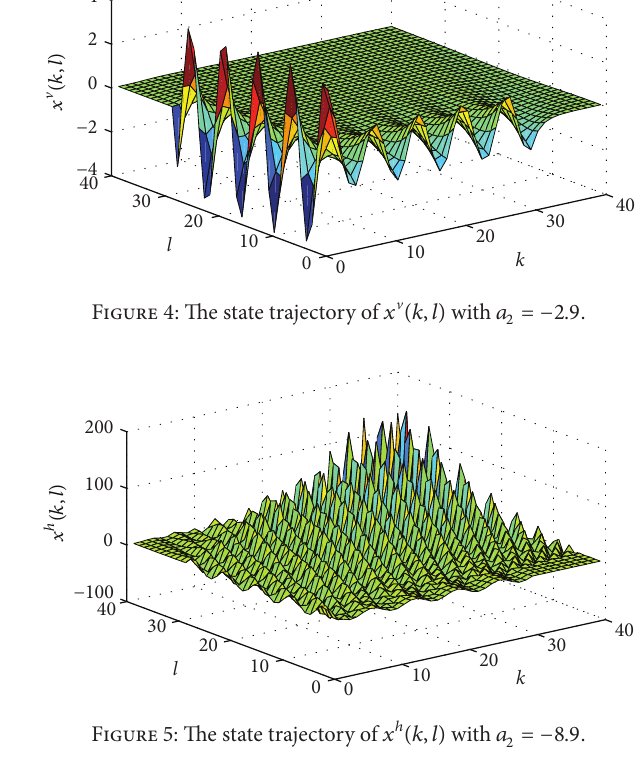
Figure 5: The state trajectory of 𝑥 ℎ (𝑘, 𝑙) with 𝑎 2 = −8.9 .